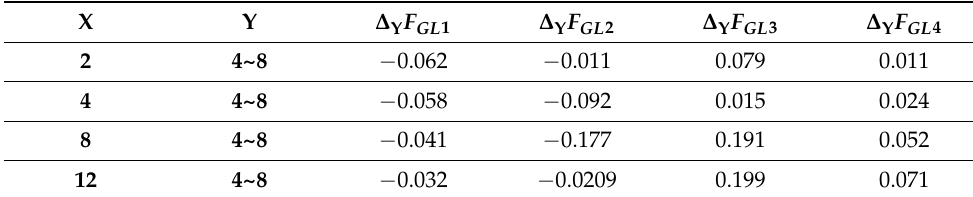
Table 1. Geometric factors changing when room dimensions change for X = 2~12 and Y = 4~8. (The negative numbers show decreasing and the positive numbers show increasing of the geometric factors with increasing Y).